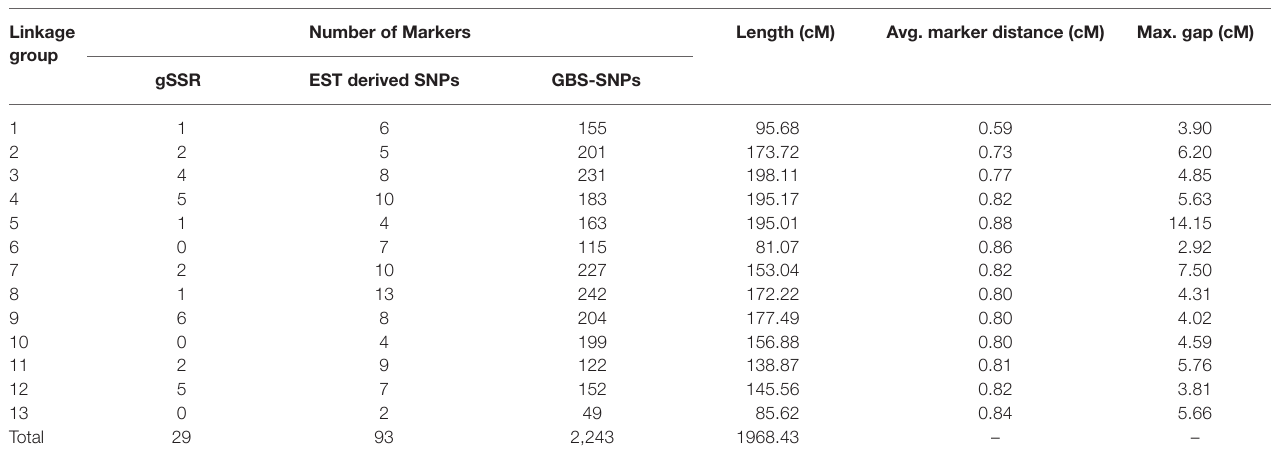
Number of Markers Length